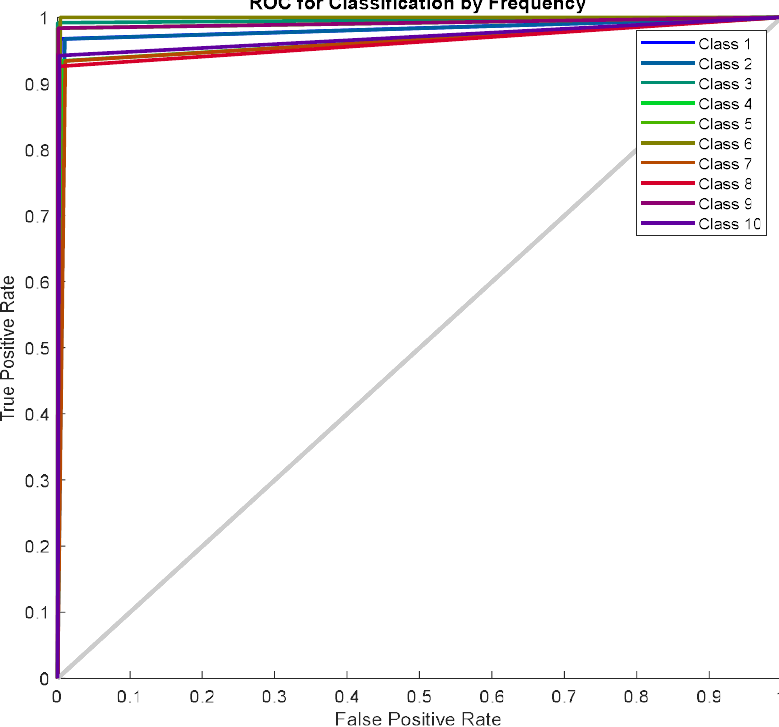
= 19.0005. (cid:3042)